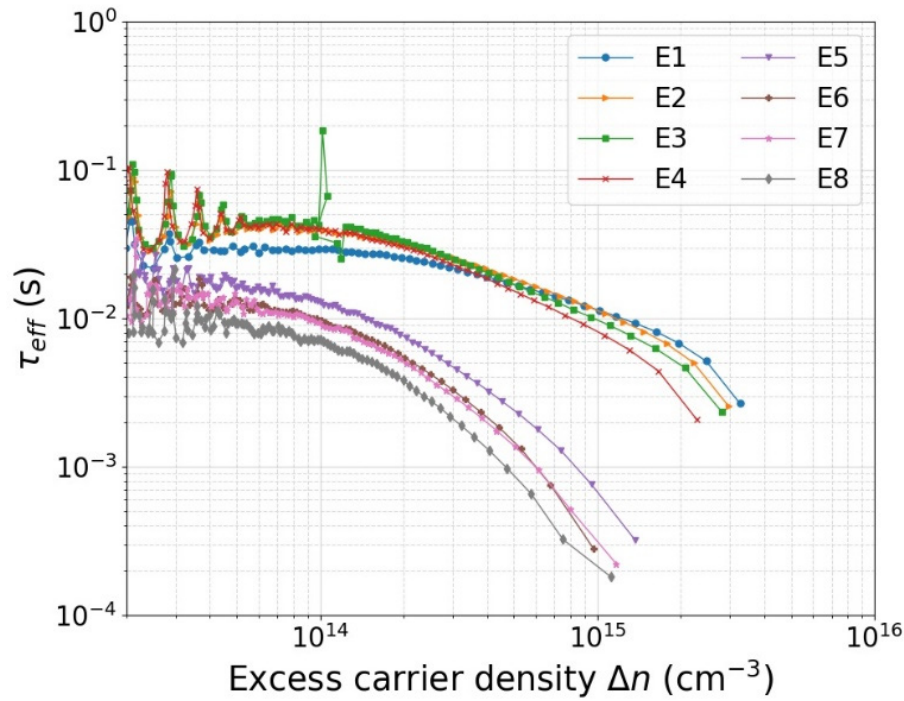
Figure 8. Effective lifetime τ eff vs. excess carrier density ( ∆ n ) for samples prepared with passivation processes described in Table 1.